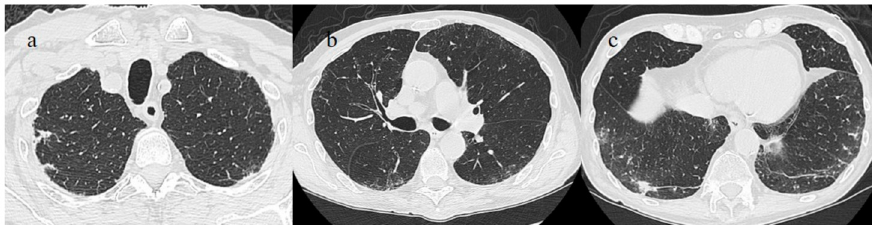
Figure 8. Chest CT performed 13 July showing some small consolidation areas with a peripheral and posterior distribution in the superior lobes ( a ), part of the superior ad inferior lobes ( b ) and at the basal level of the inferior lobes ( c